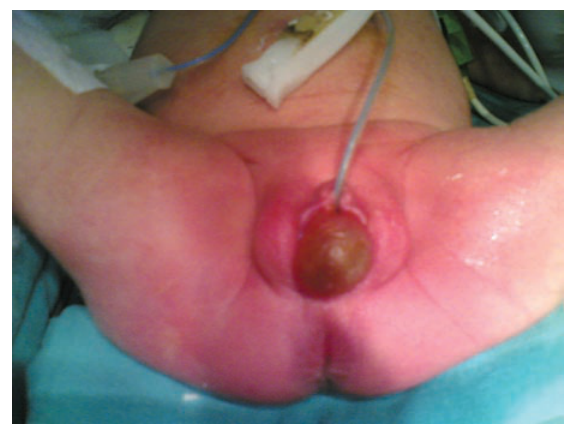
Figure 1. The mass in the interlabial region is seen on the midline, posterior to the urethral orifice.